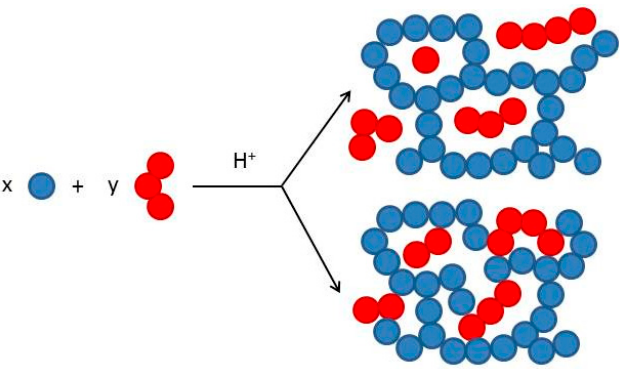
Figure 4. Possible reaction mechanisms between furanic unit ( Blue ) and phenolic moieties ( Red ).